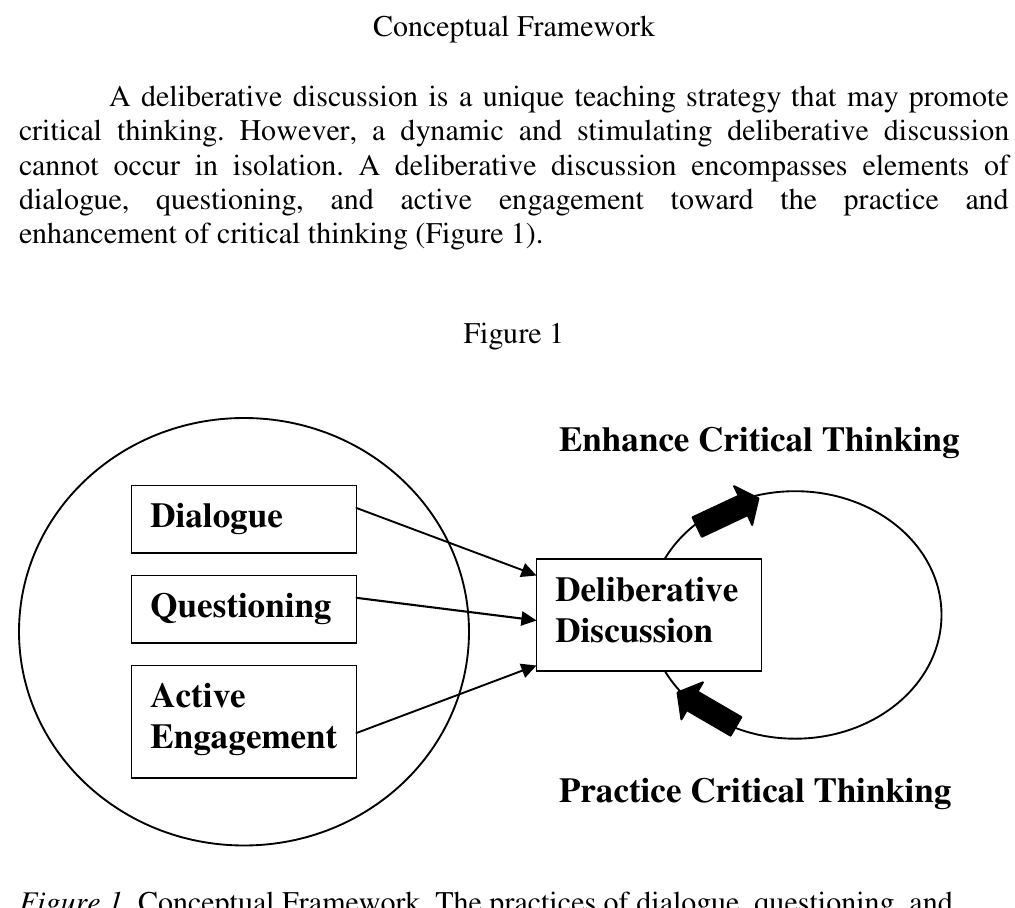
Figure 1. Conceptual Framework. The practices of dialogue, questioning, and active engagement are mutually interactive and necessary elements of deliberative discussion that allow learners the opportunity to practice and enhance critical